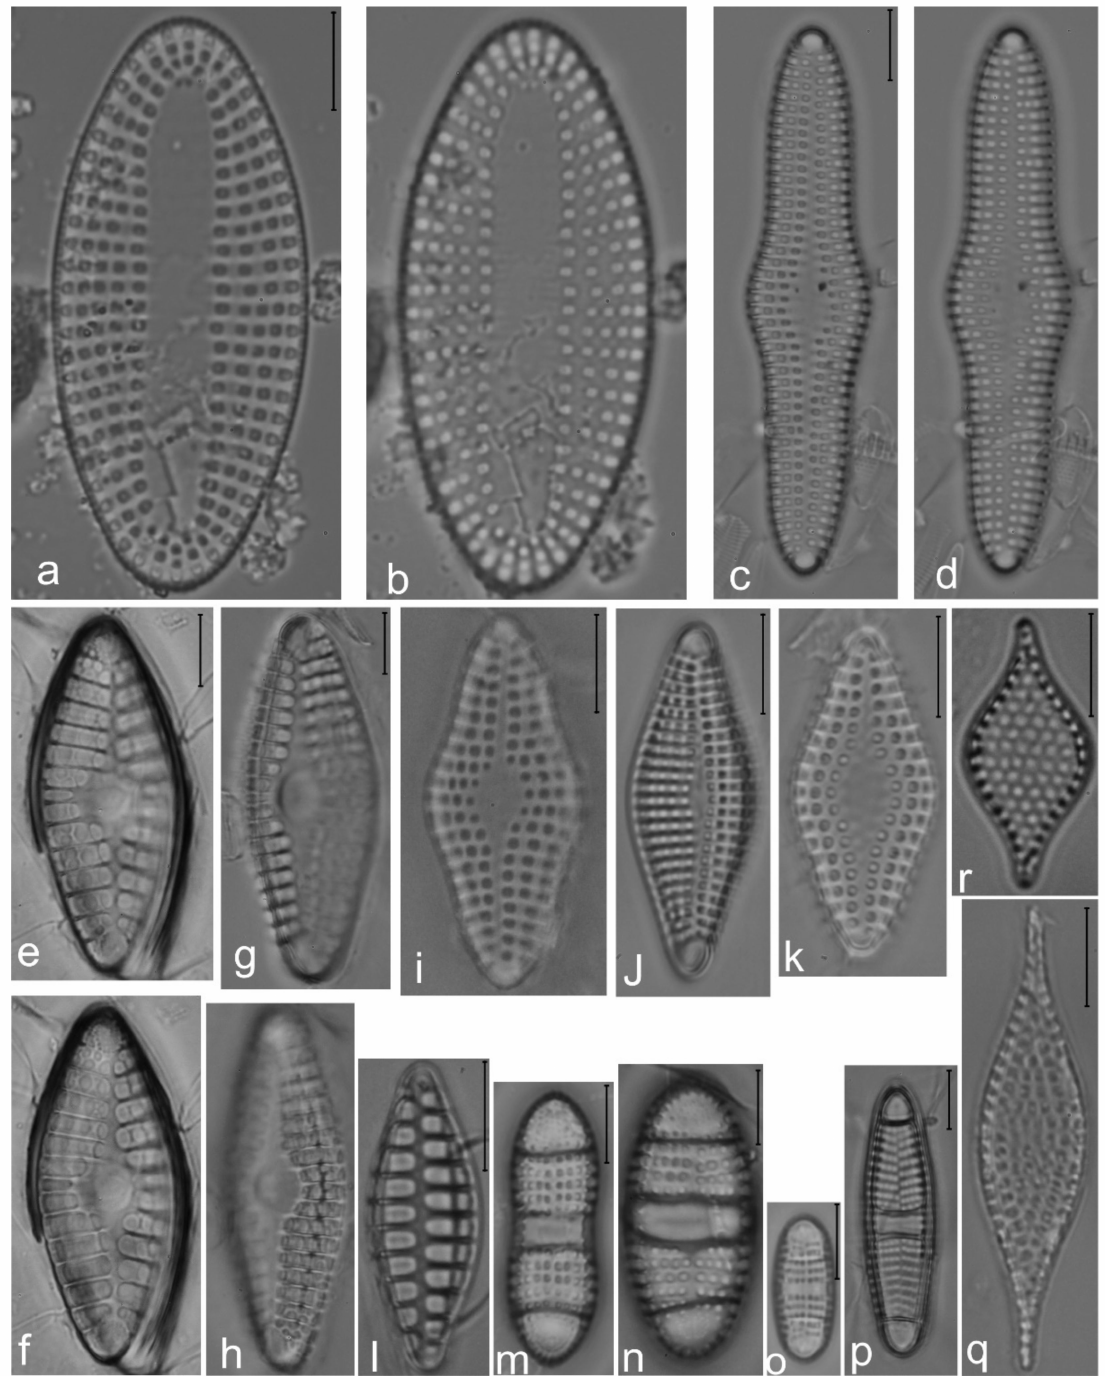
Figure 9. ( a , b ) Delphineis livingstonii ; ( c , d , i ) Dimeregramma marinum ; ( e – h ) Glyphodesmis eximia ; ( j , k ) Plagiogramma minus ; ( l ) Neofragilaria anomala ; ( m , o ) Plagiogramma pulchellum var. pygmaeum ; ( n ) P . rhombicum ; ( p ) P . pulchellum var. pulchellum ; ( q , r ) Cymatosira lorenziana . Scale bar = 10 µ